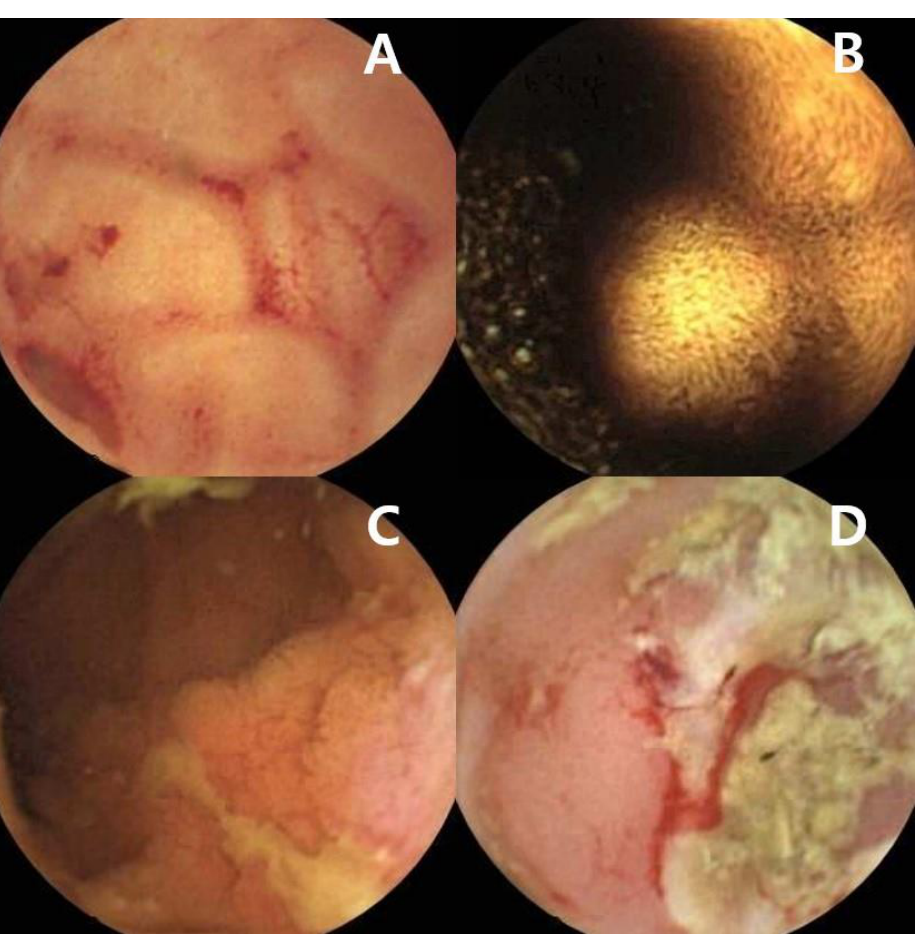
Figure 2. Small intestinal images captured by capsule endoscopy (A ) Angioectasias of the jejunum. ( B ) Gastrointestinal stromal tumor of the jejunum. ( C ) Longitudinal ulcer of the ileum in a patient with Crohn’s disease. ( D ) Ileal ulcer with spontaneous bleeding in a patient with NSAID-induced enteropathy.